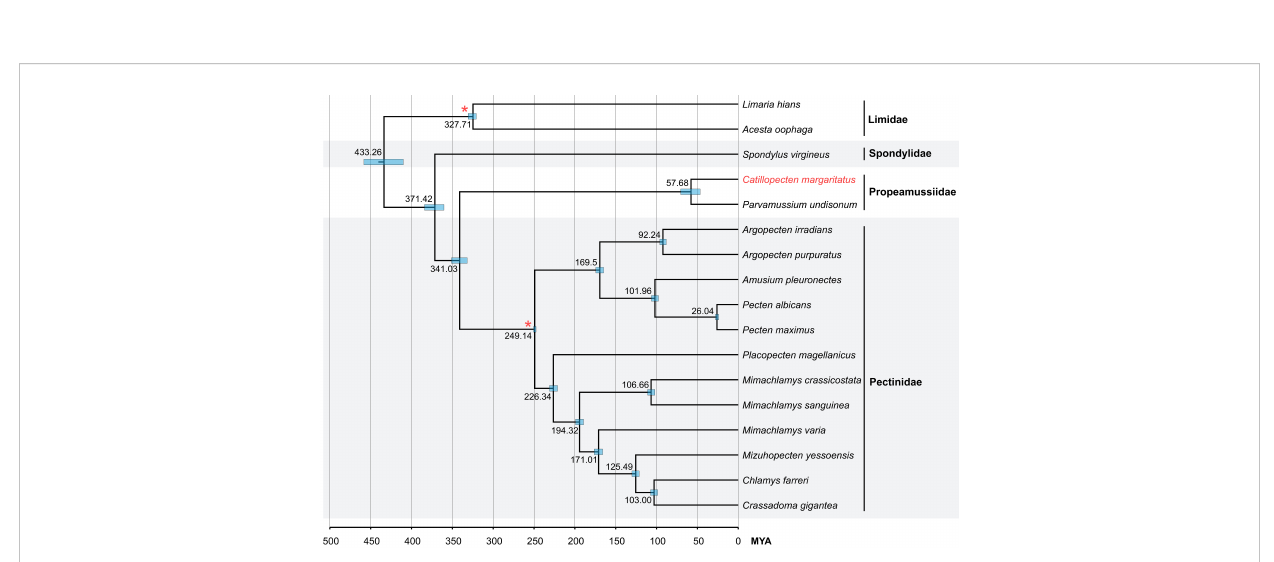
FIGURE 6 Divergence time estimation analysis of Pectinoidea based on concatenated mitochondrial PCG gene sequences. Bottom axis represents millions of years and the internal nodes calibrated by fossil records are represented by red asterisks. The 95% highest posterior density (HPD) is indicated as node blue bars and the Bayesian posterior probabilities of all nodes are 1.00.